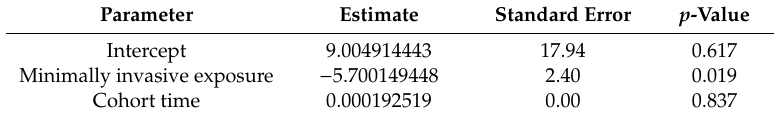
Table 4. Multivariable analysis for independent predictors of postoperative length of stay.